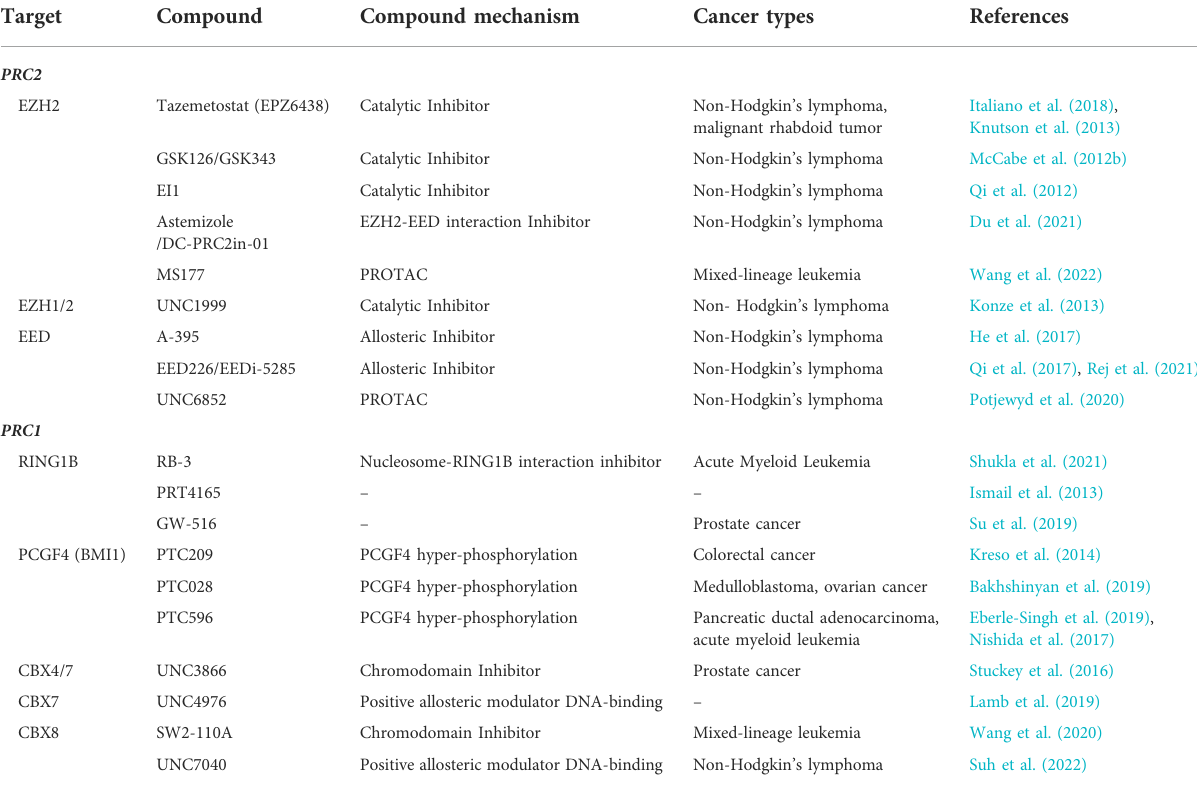
TABLE1PRC1andPRC2complextargetingcompounds.TabledetailingthepublishedsmallmoleculecompoundsthattargetPRC1orPRC2complex members and the mechanism of their targeting